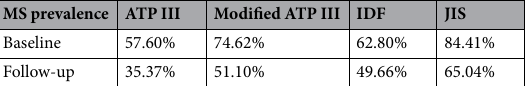
Table 2. The prevalences of MS according to four MS criteria among patients with hypertension. MS: metabolic syndrome, ATP III: the Adult Treatment Panel III (part of the 2001 US Third Report of the National Cholesterol Education Program), Modified ATP III: the 2004 modification of the ATP III for Asian populations, IDF: the 2005 criteria from the International Diabetes Federation, JIS: the 2009 criteria from the Joint Interim